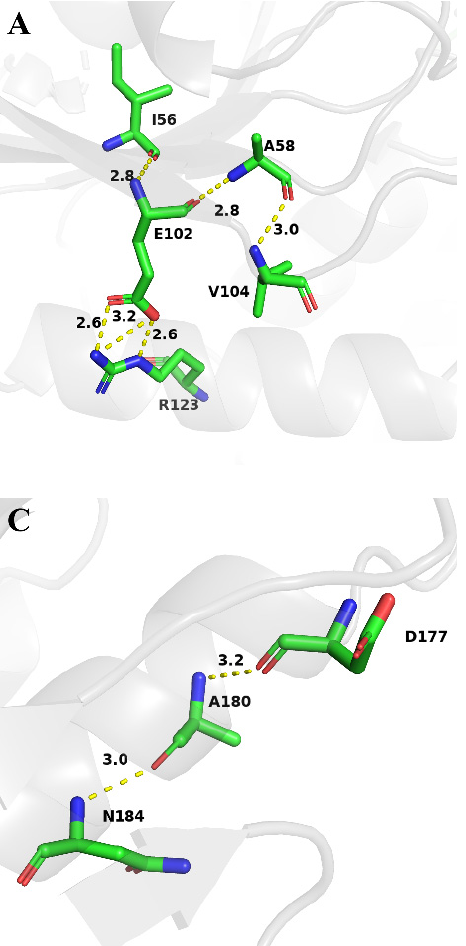
10 of 16 Table 5. The size and shape description of substrate binding pockets.